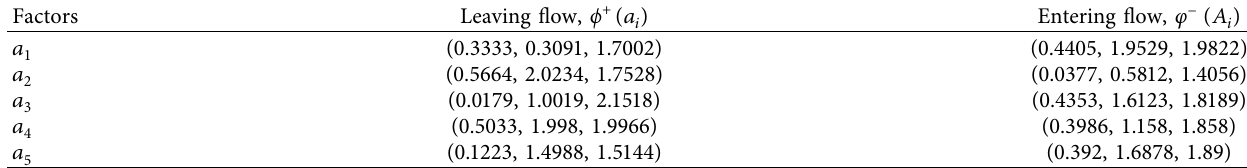
Figure 2: Fuzzy PROMETHEE I partial preorder value outranking graph. Table 16: Fuzzy PROMETHEE flow in the form of ( M,a, b ) .